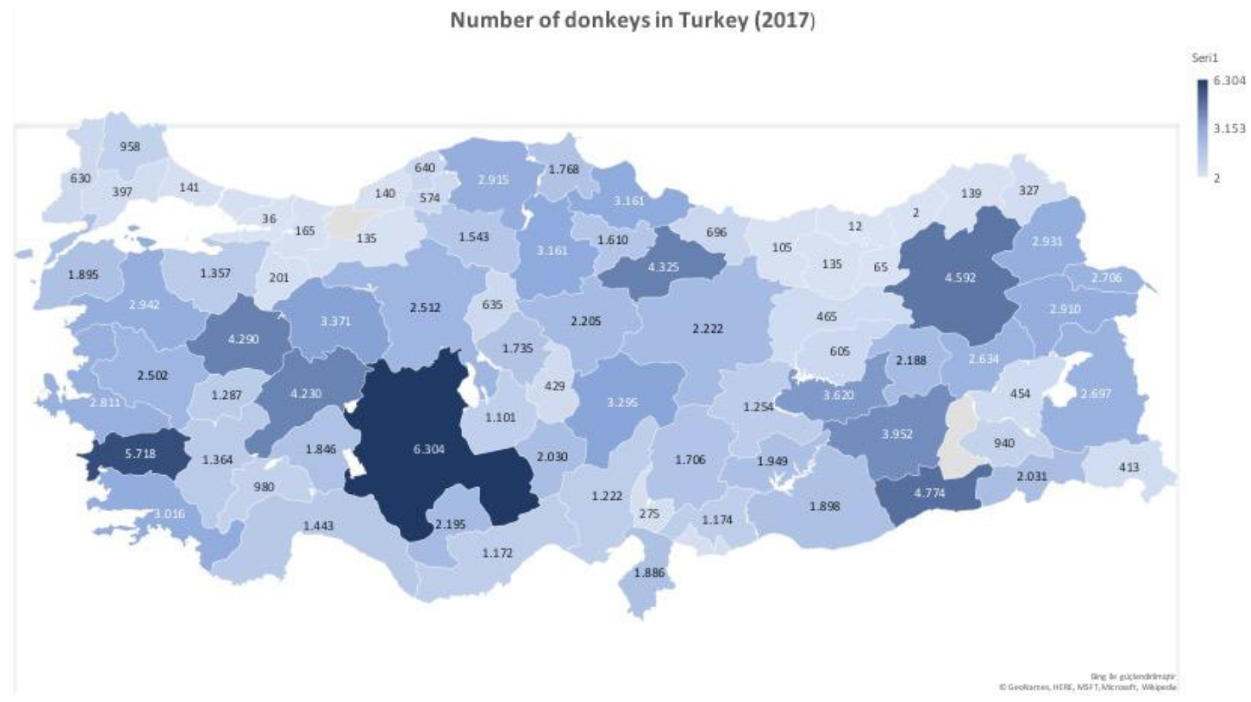
Figure 1. The sampling locations and the sample sizes of donkeys used in this study (©GeoNames, Microsoft, Navteq, Wikipedia).